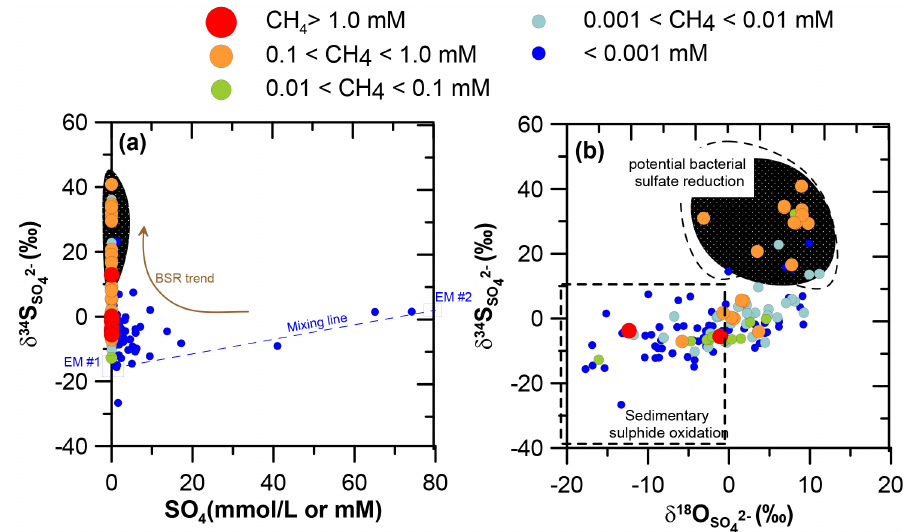
Figure 9. Cross plot of δ 34 S and δ 18 O values and sulfate concentrations (mM) and identification of groups of data according to sulfate origin and formation processes. Dissolved methane concentrations are reported as colored symbols.